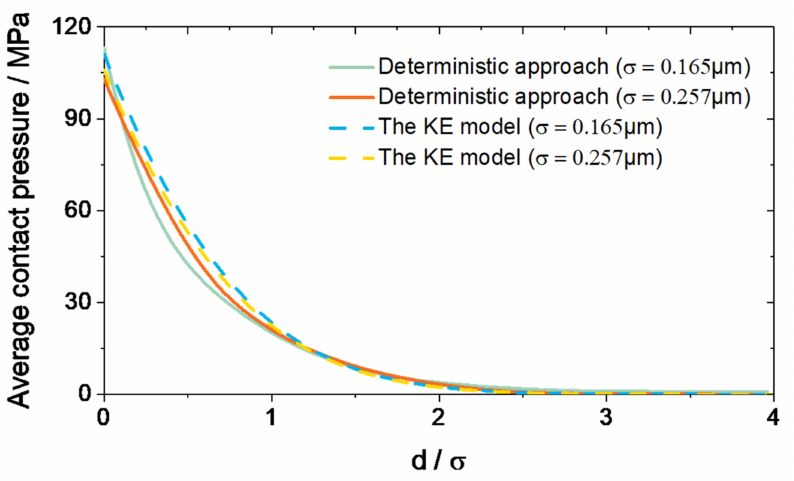
Figure 5. The variations of the average contact pressure versus the separation of the contact surfaces using the KE model and the deterministic